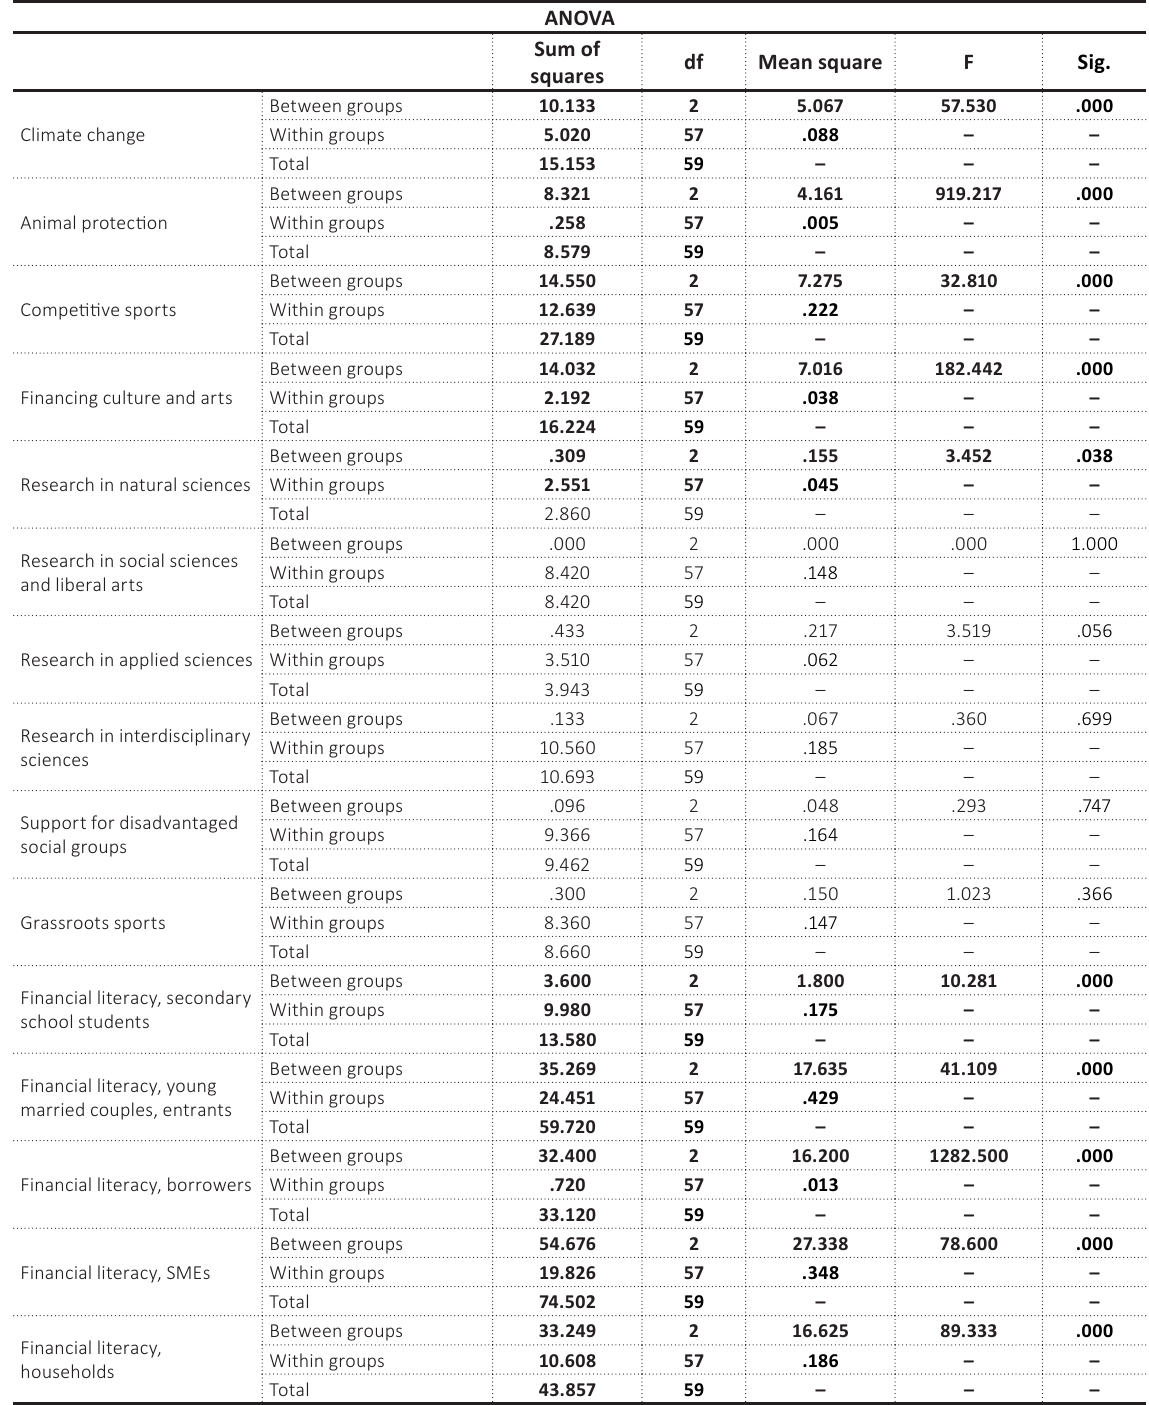
Table 4. Variance analysis